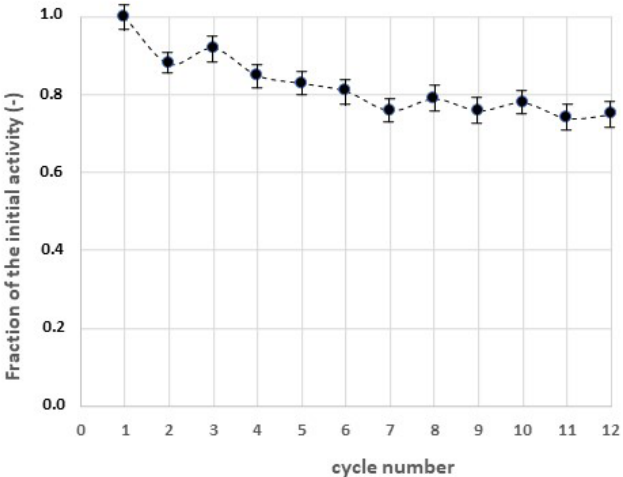
Figure 7. Multiple cycles of adsorption of methylene blue in the presence of chitosan hydrogel with immobilized laccase. S/L ratio = 1/100, contact time = 120 min.